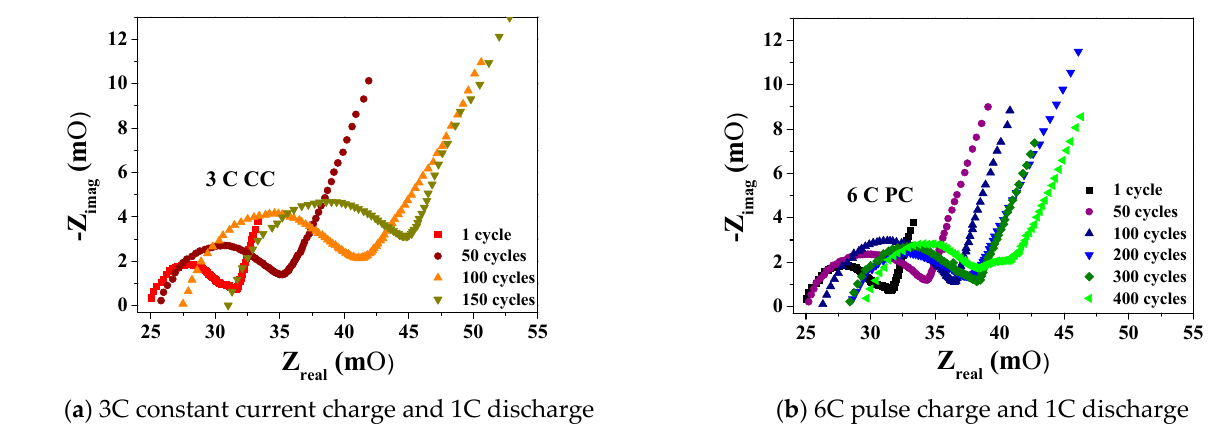
Figure 7. Electrochemical impedance spectrum (EIS) depending on charging methods.